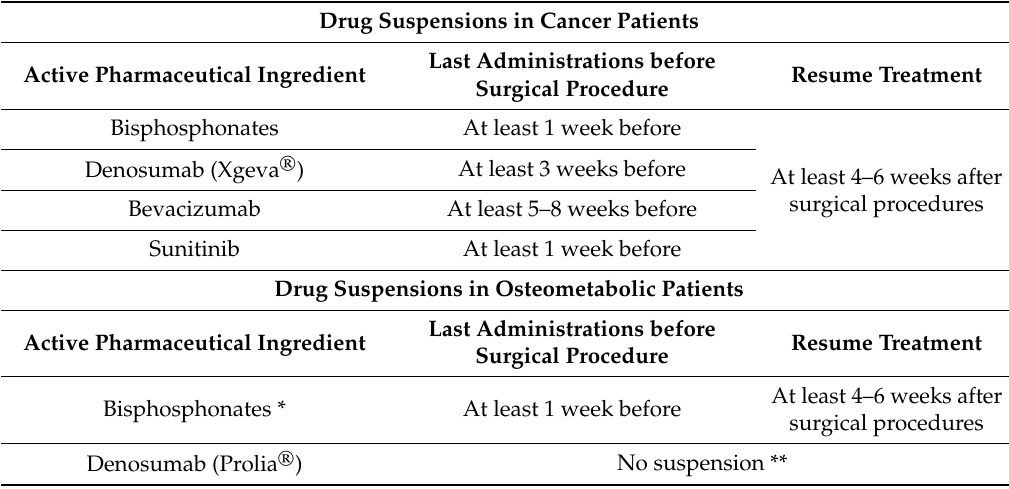
Table 2. Drug suspensions proposed for cancer and osteometabolic patients